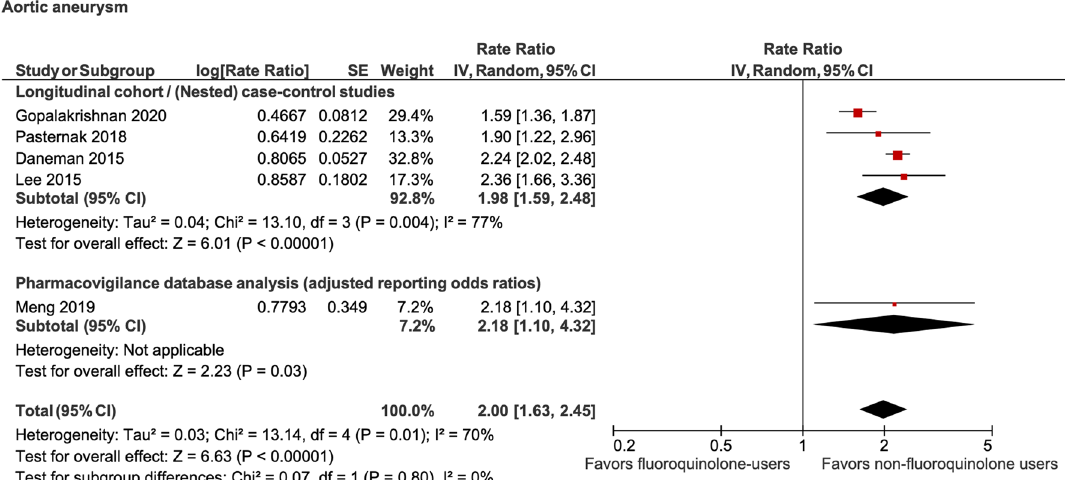
Figure 3. Association between fluoroquinolone use and aortic aneurysm.